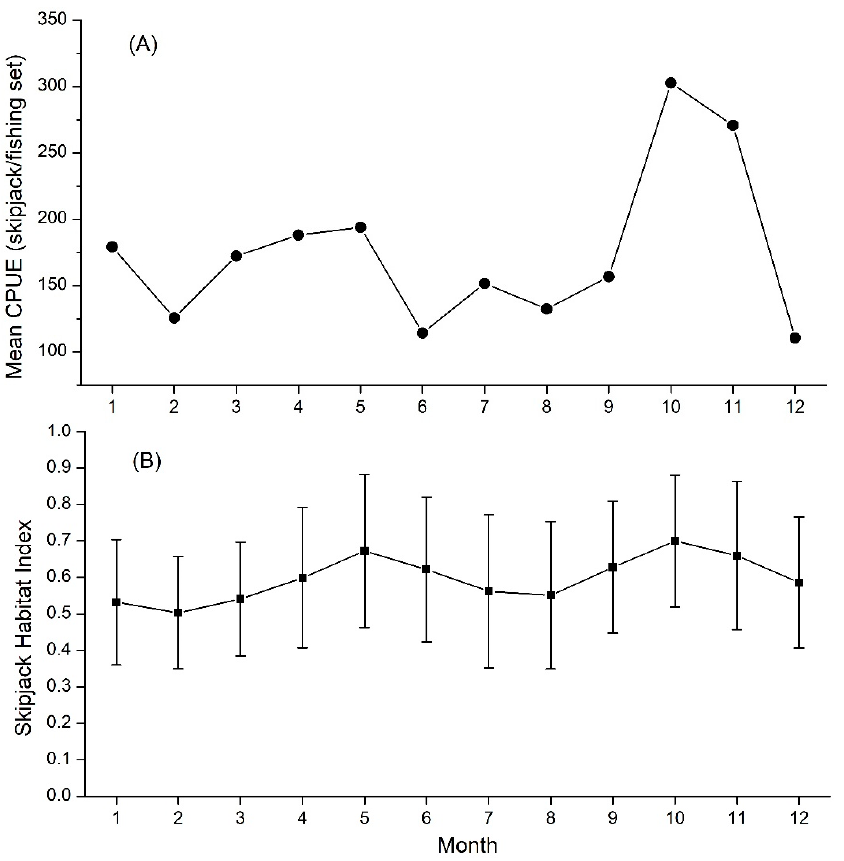
Figure 6. Temporal variability of mean skipjack CPUE ( A ) and skipjack habitat index/SHI ( B ) from January to December 2007–2016.